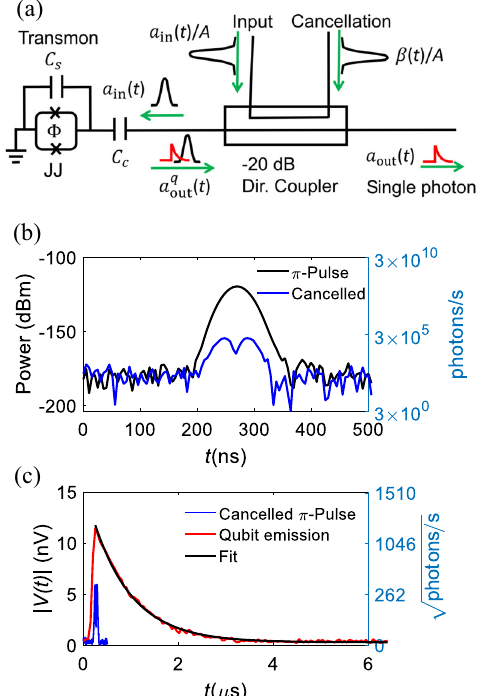
Fig. 1 Pulse cancellation. a Schematic for generating single photons using pulse cancellation. A fl ux-tunable transmon-type superconducting qubit (arti fi cial atom) capacitively coupled to the end of an open transmission line with a − 20 dB directional coupler connected to the transmission line. C s and C c represent the shunt capacitance for the qubit and the coupling capacitance between the qubit and the transmission line, respectively. Φ is the external magnetic fl ux threading the SQUID (Superconducting QUantum Interference Device) loop and JJ denotes the Josephson junctions. b Comparison of a π -pulse with and without the cancellation when the qubit is tuned away. The input pulse is suppressed by − 33.5 dB with a cancellation pulse with 5.12 × 10 5 averages. c Comparison between the canceled π -pulse from b and the photon emission by the qubit (red line) after a π /2-pulse with the pulse cancellation on. The red line is a fi t to an exponential decay to extract Γ 2 /(2 π ) = 193 ± 4